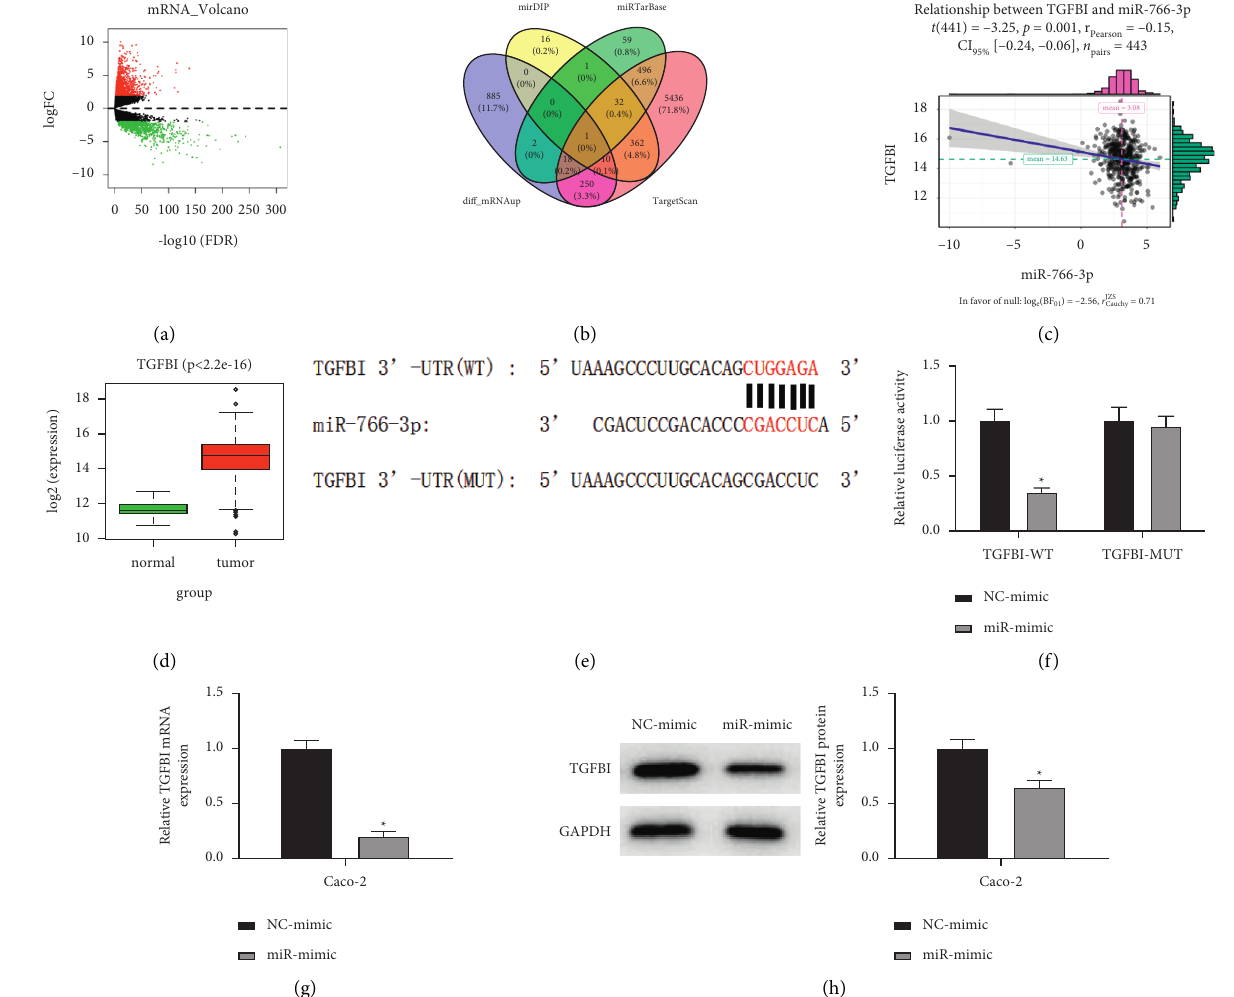
Figure 3: MiR-766-3p inhibits TGFBI expression in colon cancer. (a) Volcano map of DEmRNAs in normal and tumor groups. (b) Venn diagram of DEmRNAs and predicted target mRNAs. (c) Correlation of miR-766-3p and TGFBI. (d) Box plot of the TGFBI level in normal and tumor groups. (e) Binding of miR-766-3p on TGFBI 3 ′ UTR predicted by bioinformatics analysis. (f) Dual-luciferase assay measuring the luciferase activity in different treatment groups of the cancer cell line Caco-2. (g) TGFBI mRNA level in colon cancer cells Caco-2 upon miR-766-3p overexpression. (h) TGFBI protein level in colon cancer cells upon miR-766-3p overexpression. ∗ P < 0 .